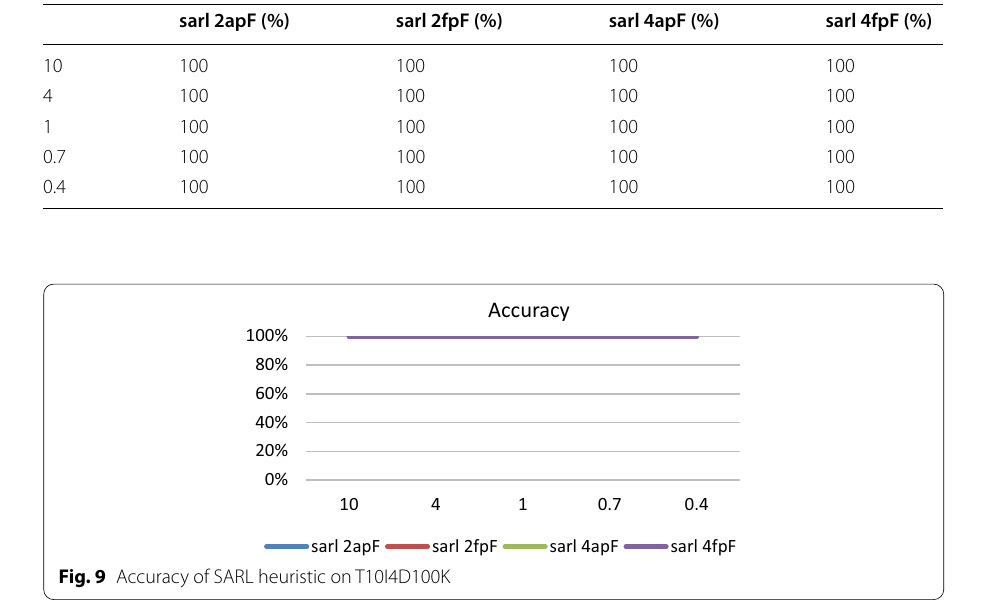
Table 16 Accuracy of SARL heuristic on T10I4D100K